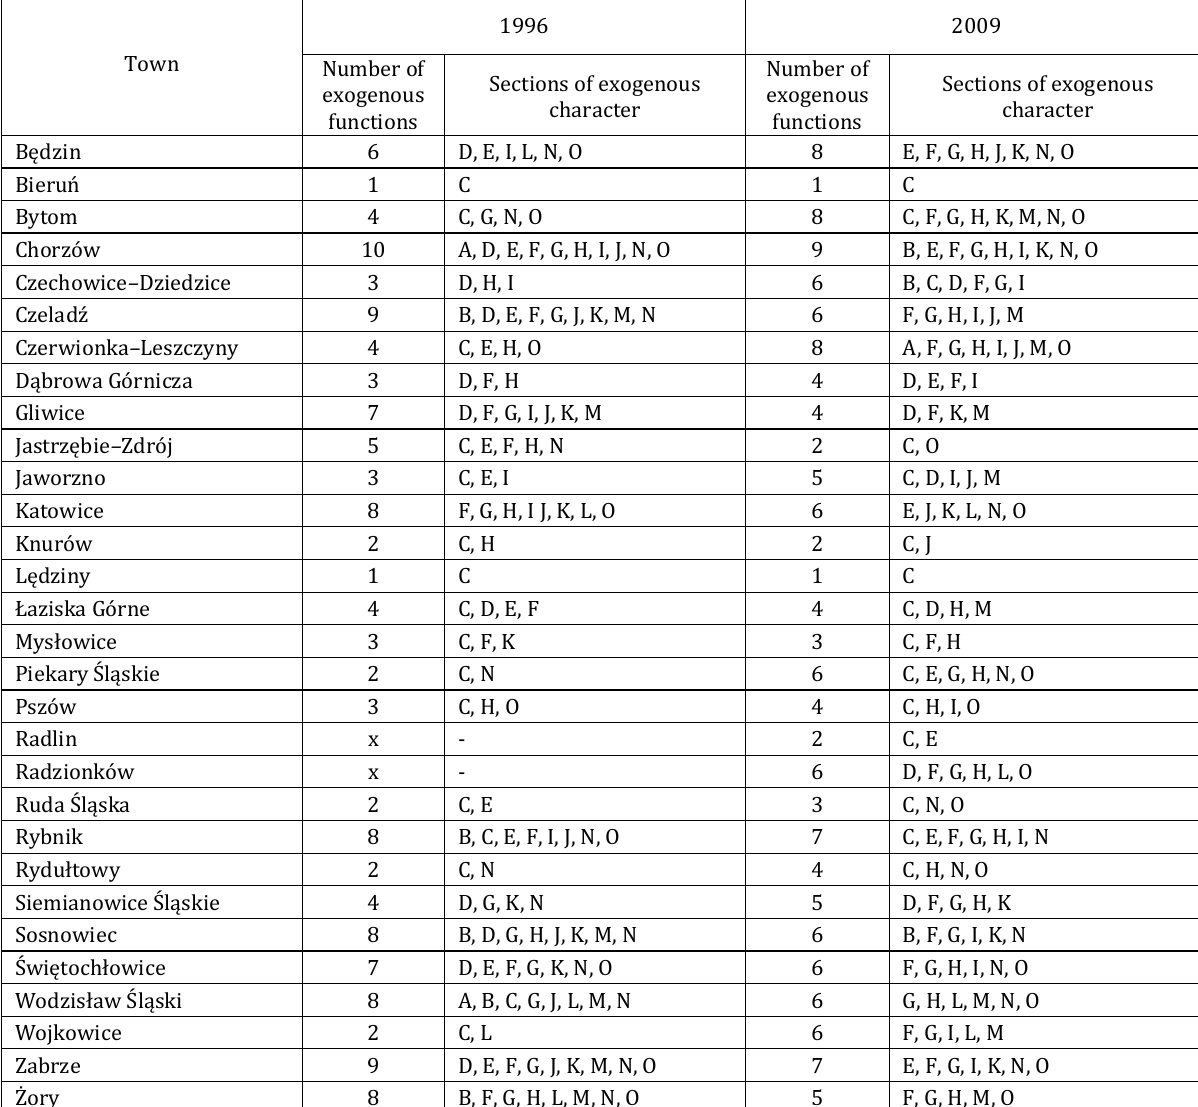
Table 3. Structure of exogenous functions of towns in the Silesian voivodeship in 1996 and 2009 (author’s compilation) Town